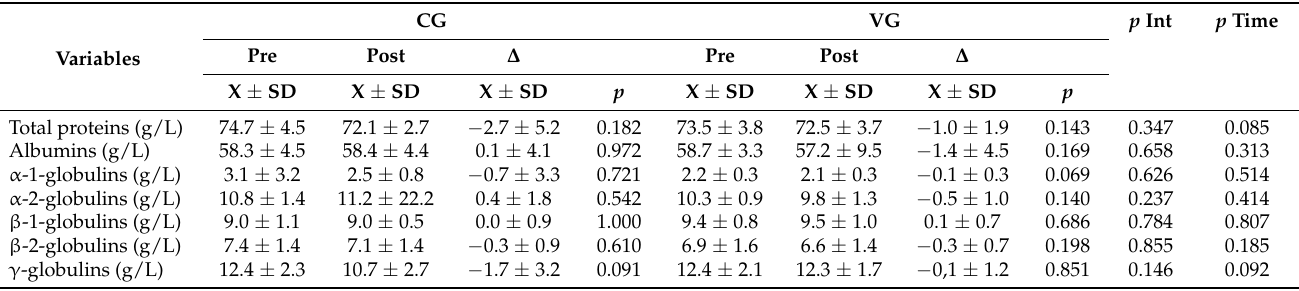
Table 5. Values of the protein profile parameters and their differences ( ∆ ) in the control (CG) and examined (VG) groups before and after three vibrotherapy series, considering interactions between the groups ( p int) and changes over time ( p